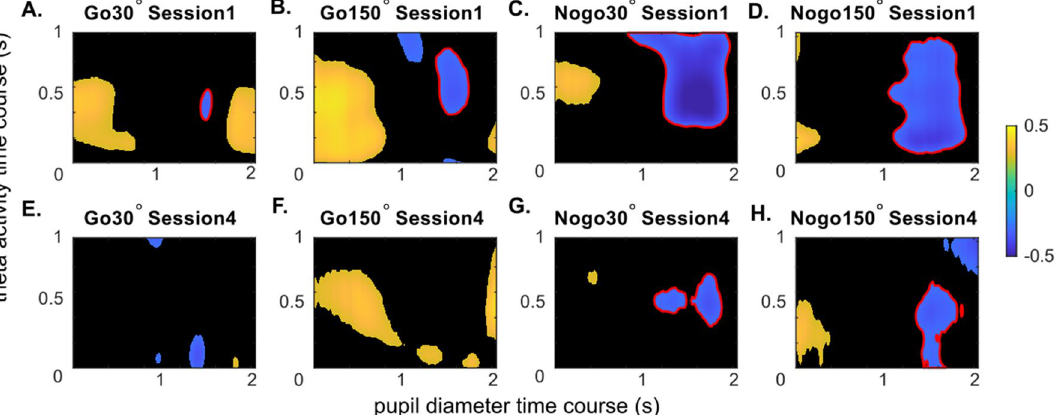
Figure 5. Correlation between theta activity and pupil diameter. Figure parts ( A – H ) shows the correlation coefficient matrix between source level task-related theta activities (dB) and phasic pupil diameter (baseline- corrected) in each condition and session. The x-axis refers to the time window of pupil diameter, which is 0 to 2 s; the y-axis refers to the time window of theta activity, which is 0 to 1 s. Only significant coefficients ( p ≤ . 05) are shown. Black areas represent non-significant coefficients ( p > .05). Red lines mark the boundaries of the negative correlation clusters of interest in each plot. The correlation coefficient (r) is colour coded. Warm colours denote positive correlations coefficients, cold colours negative correlation